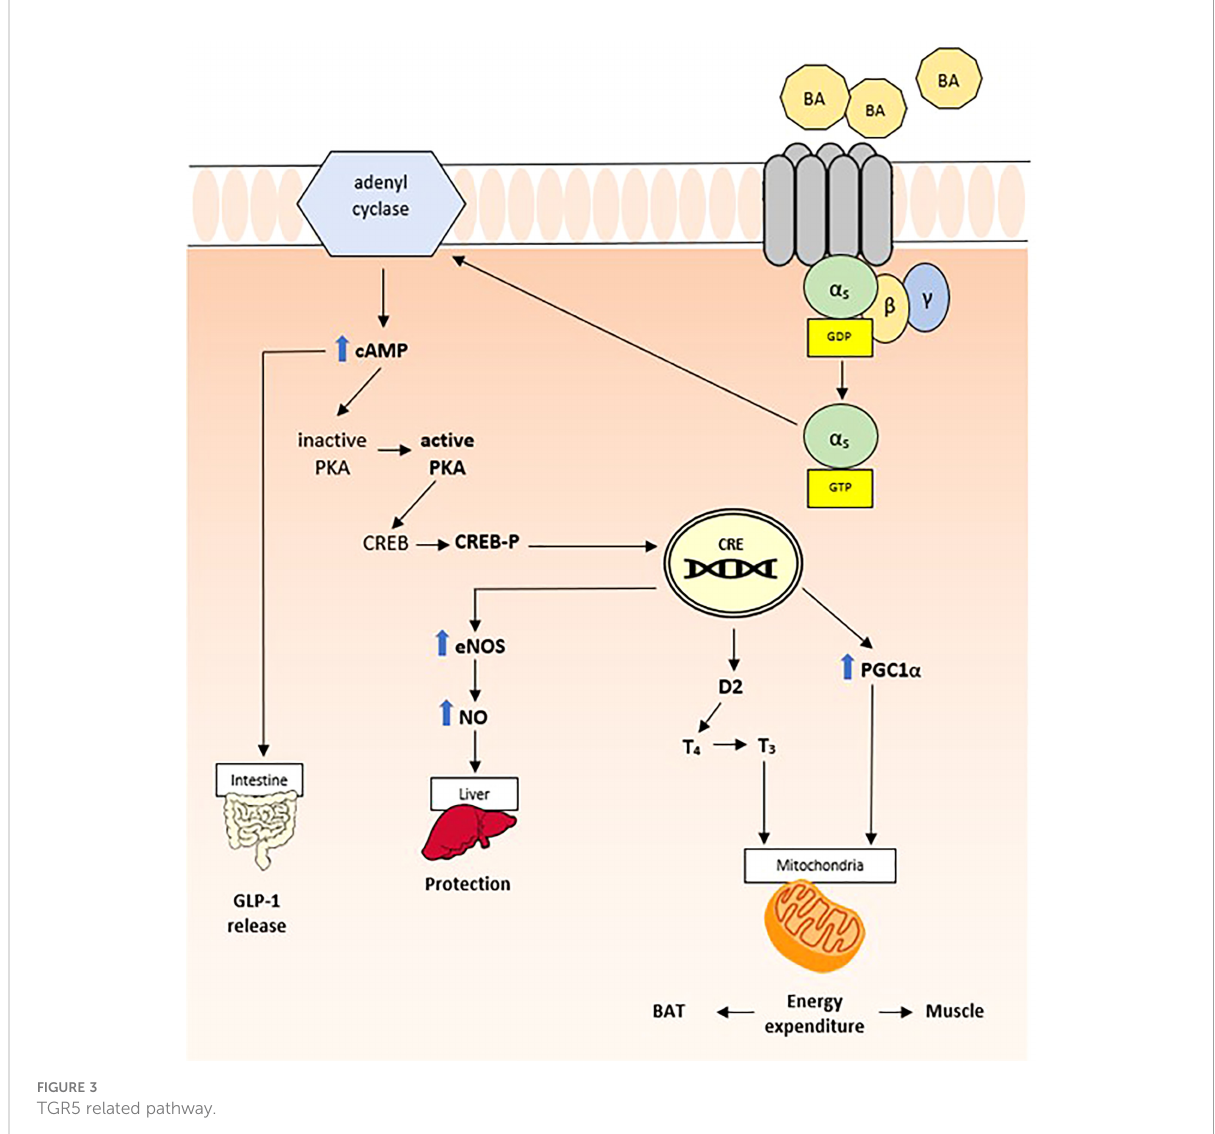
FIGURE 3 TGR5 related